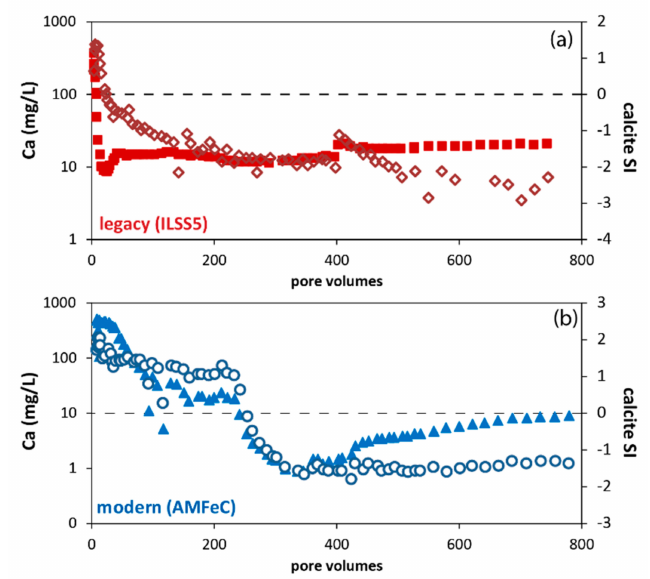
Figure 6. Concentration of calcium (solid symbols) and Saturation Index (SI) (open symbols) for calcite for e ffl uent from the phosphate removal column experiments using modern and legacy slag from the Chicago-Gary area, Illinois and Indiana. ( a ) Results from the legacy slag-filled column (ILSS5). ( b ) Results from the modern C-fine slag-filled column (AMFeC). Solid symbols represent the Ca concentration (left y-axis) and open symbols represent the SI (right y-axis). Dashed line represents SI equal to